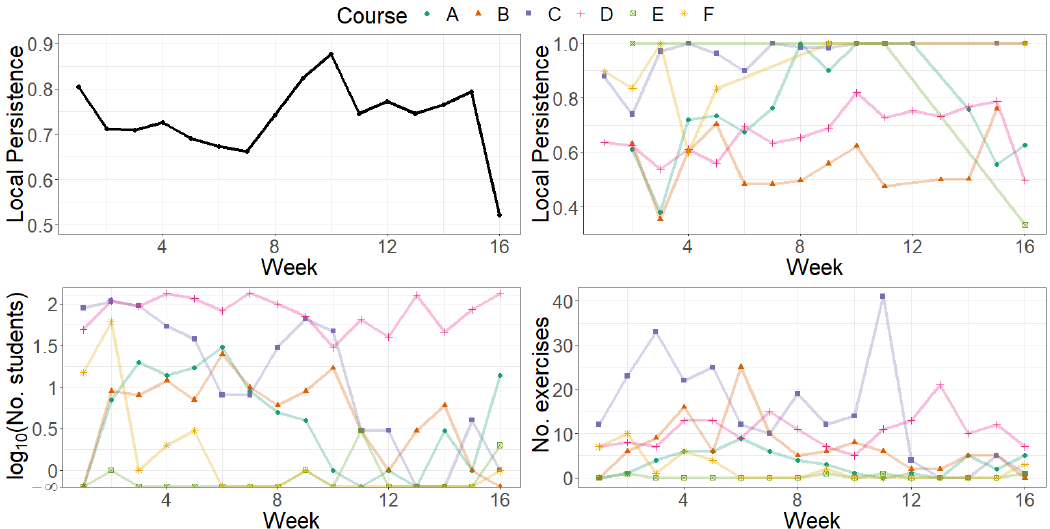
Figure 3. ( a: top-left ) Evolution of the local persistence in the first semester using all the courses, ( b: top-right ) evolution of the local persistence in the first semester for each course, where each course is a different line, ( c: bottom-left ) number of students engaging with exercises in each week of the semester for each course, ( d: bottom-right ) number of exercises students have attempted in each week of the course. Note: Actual names of the courses are omitted for confidentiality reasons.